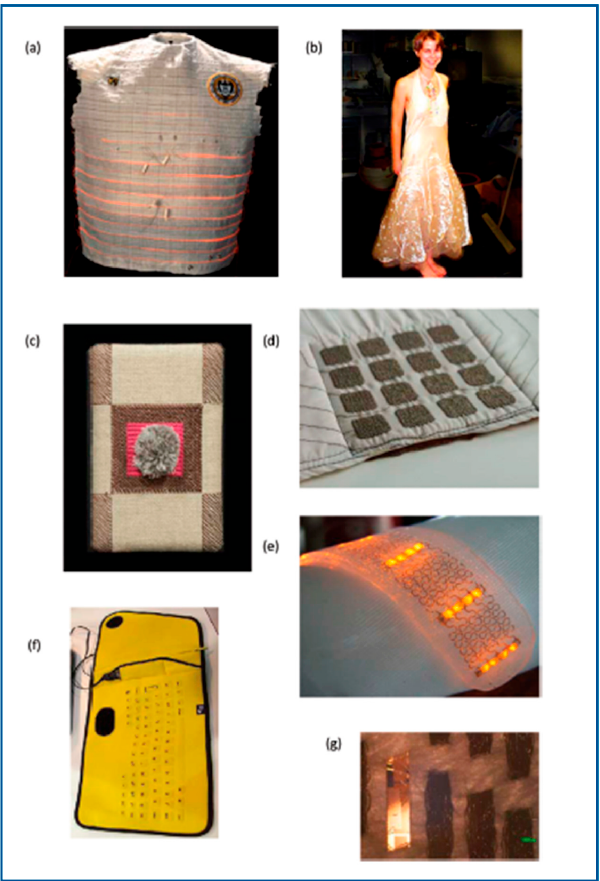
Figure 3. ( a ) Georgia Tech Wearable Motherboard (GTWM)14 From S. Park et al., “The wearable motherboard: A framework for personalized mobile information processing